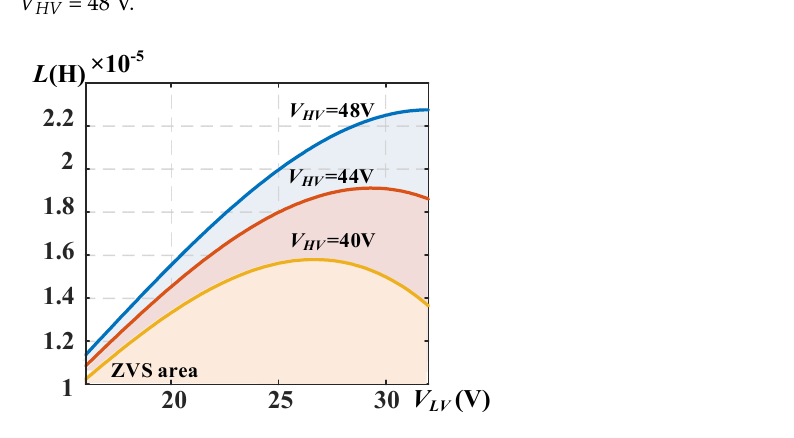
Figure 3. Critical inductance to operate in BCM with full load. The red line is the value of inductor V HV = 48 V.